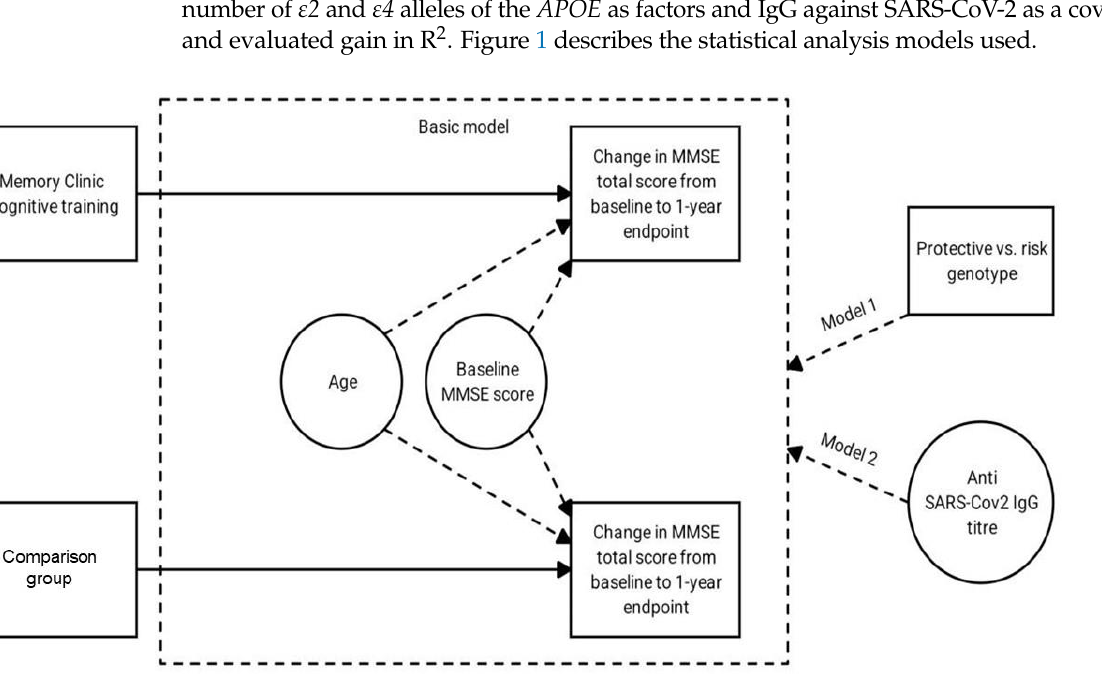
Figure 1. Graphical scheme of